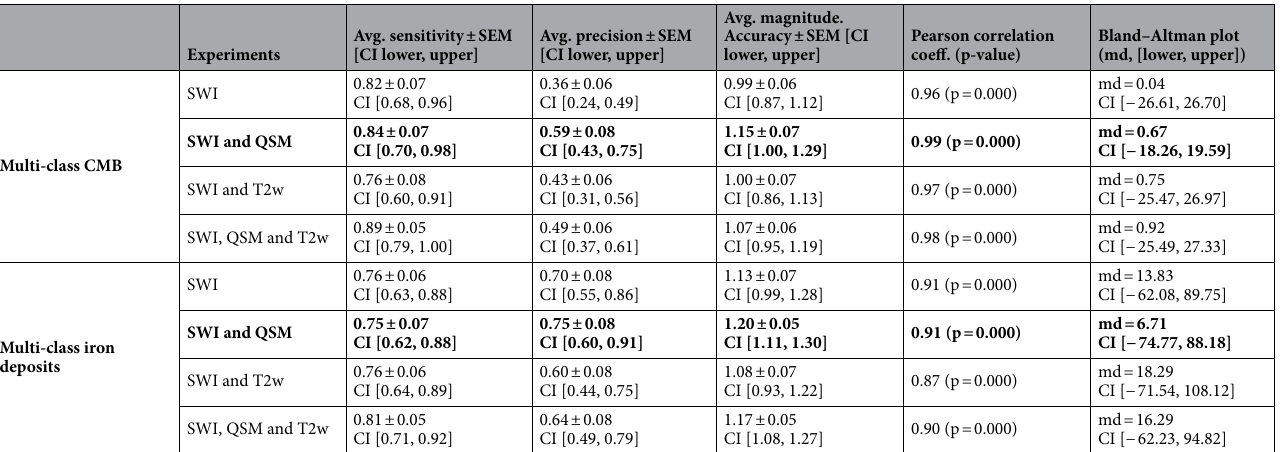
Table 2. Experimental result using the multiclass model for the number of predicted CMB and iron deposit lesions evaluated against the reference annotation. SEM standard error of the mean, md mean difference, CI confidence interval. Bold—Model with highest magnitude